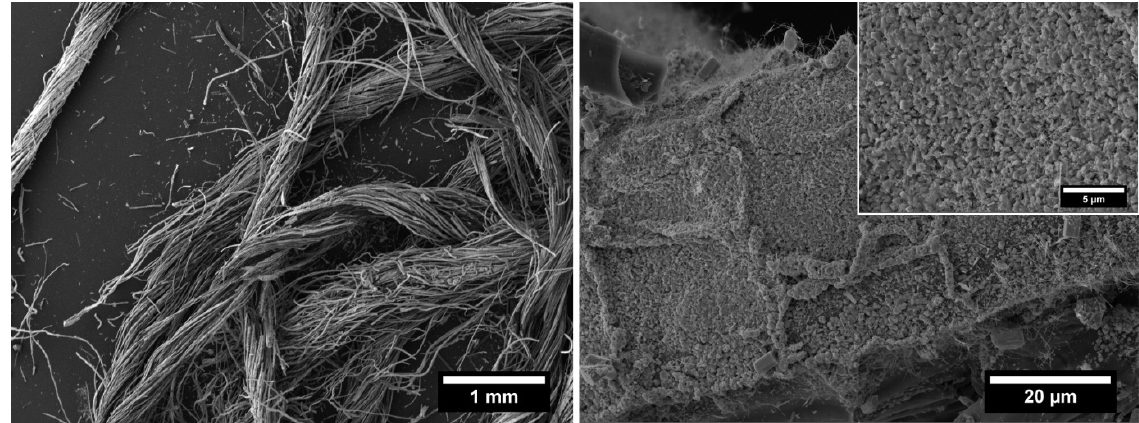
Figure 8. FESEM images at different magnifications of ZnO-coated flax yarns after the thermograv- imetric test.